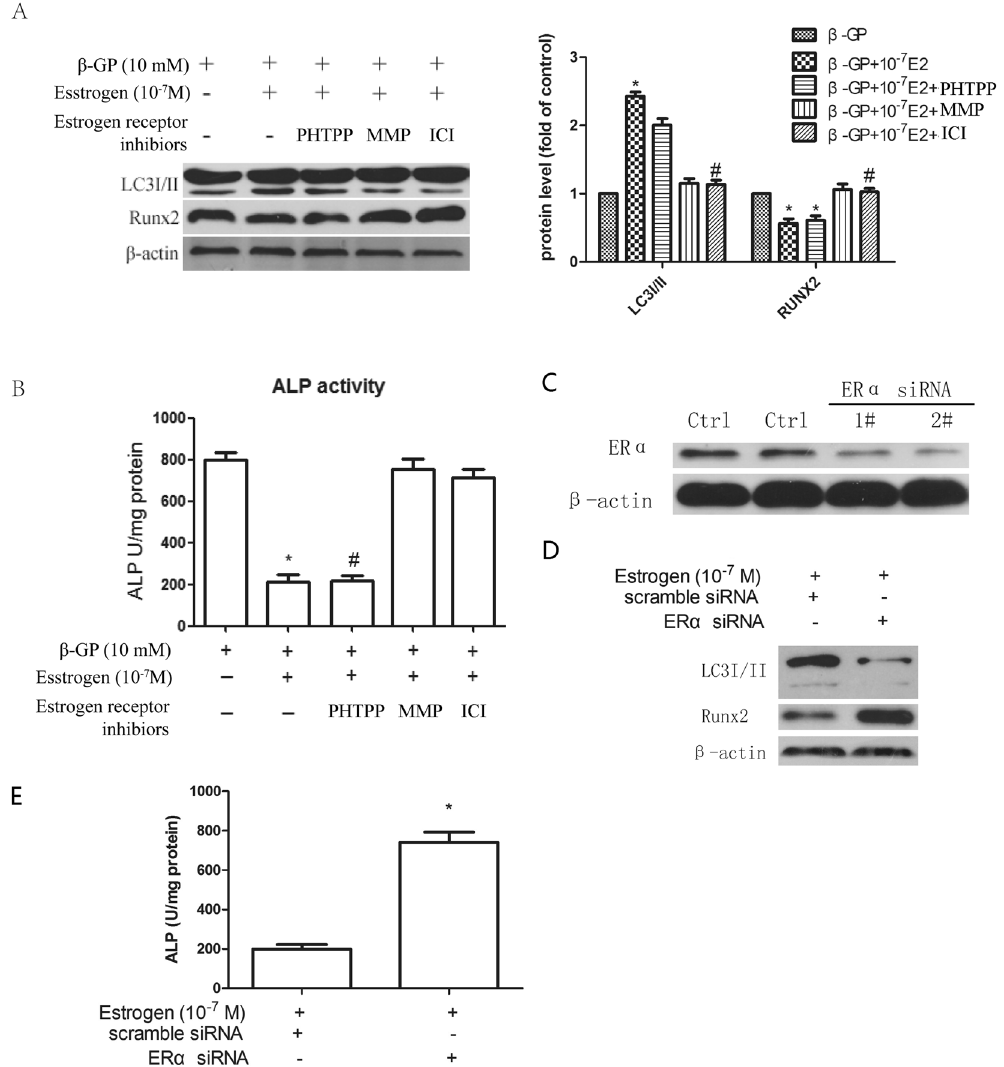
Figure 6. Autophagy is induced by oestrogen via ER α but not ER β . ( A ) VSMCs were incubated with medium containing β -GP and then pre-treated with ICI 182780 (100 nM, an ER antagonist), MPP (100 nM, a selective ER α antagonist) or PHTPP (100 nM, a selective ER β antagonist) for 30 min and subsequently incubated with oestrogen for 72 h. LC3I/II and Runx2 levels ( A ) and ALP activity ( B ) were detected using Western blot analysis or an ALP kit, respectively. * p < 0.01 compared with the cells treated with β -GP. # p < 0.01 compared with the cells treated with β -GP + oestrogen group (n = 5). ( C – E ) VSMCs were transfected with scrambled control or ER-specific siRNA for 48 h and then treated with β -GP and oestrogen for 72 h. Western blot analysis of Atg5 and Runx2 protein levels ( D ) and ALP activity detection ( E ) were performed. * p < 0.05 compared with the cells treated with oestrogen and scrambled control. Representative images are